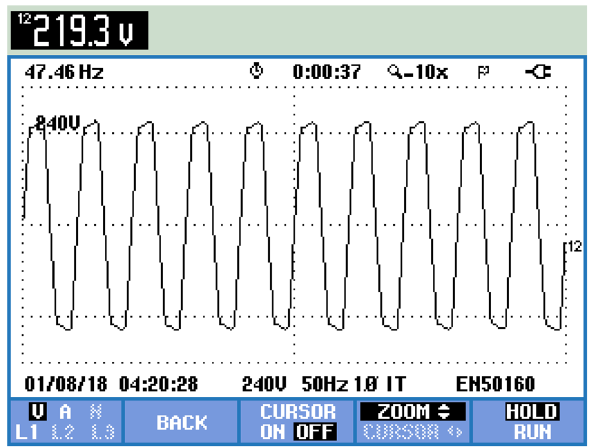
Fig. 13 Single-phase load voltage of IAG with controller EGLC